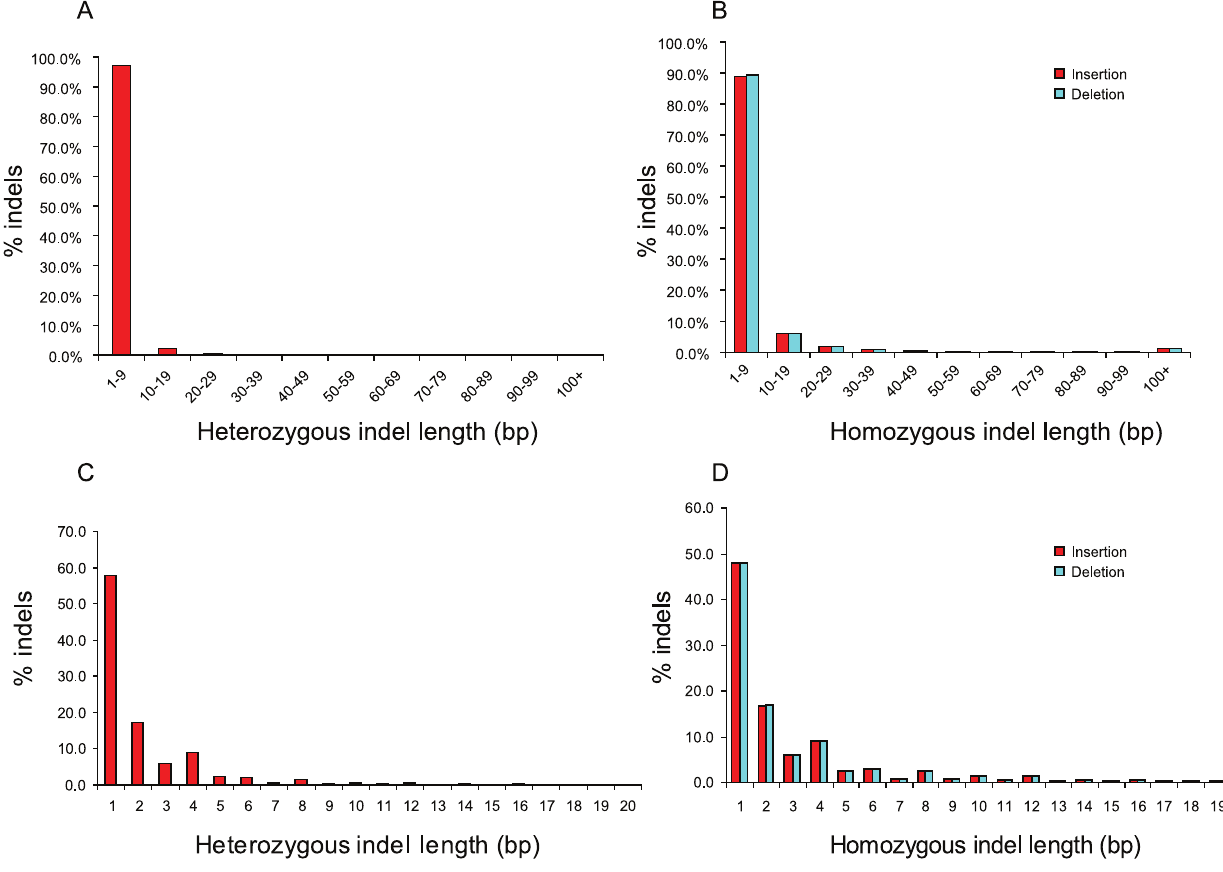
Figure 6. Distribution of Indel Length in the HuRef Genome Distributions of heterozygous (A) and homozygous (B) indels lengths of 1–100 bp (A and B, respectively) and at greater detail in the range 1–20 bp (C and D, respectively). Note that heterozygous indels range from 1–321 bp and homozygous indels between 1–82,711 bp, however both polymorphisms type have greater than 47% of indel events being single base. Also even-length indels appear to be overrepresented.